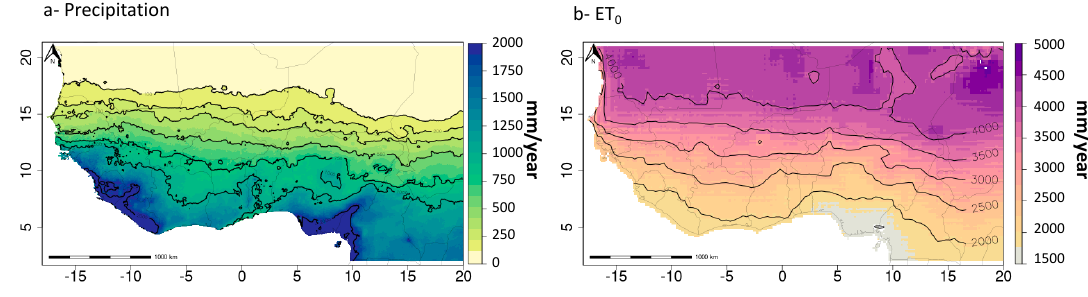
Figure 1. ( a ) Isohyets across West Africa, ranging from 100 mm/year in the far north of the Sahel to over 2000 mm/year in the south of West Africa (The amount of precipitation per year was capped at 2000 mm/year). Isohyets were calculated using yearly rainfall from the Climate Hazards InfraRed Precipitation with Stations dataset from 1981–2016 [26]. ( b ) Isopleths of ET 0 across West Africa, ranging from 5000 mm/year in the far north of the Sahel to under 1500 mm/year in the far south. (The amount of ET 0 was capped at 5000 mm/year). Isopleths of ET 0 used the ET 0 dataset produced by the National Oceanic and Atmospheric Administration’s Physical Sciences Division from 1981 to 2016